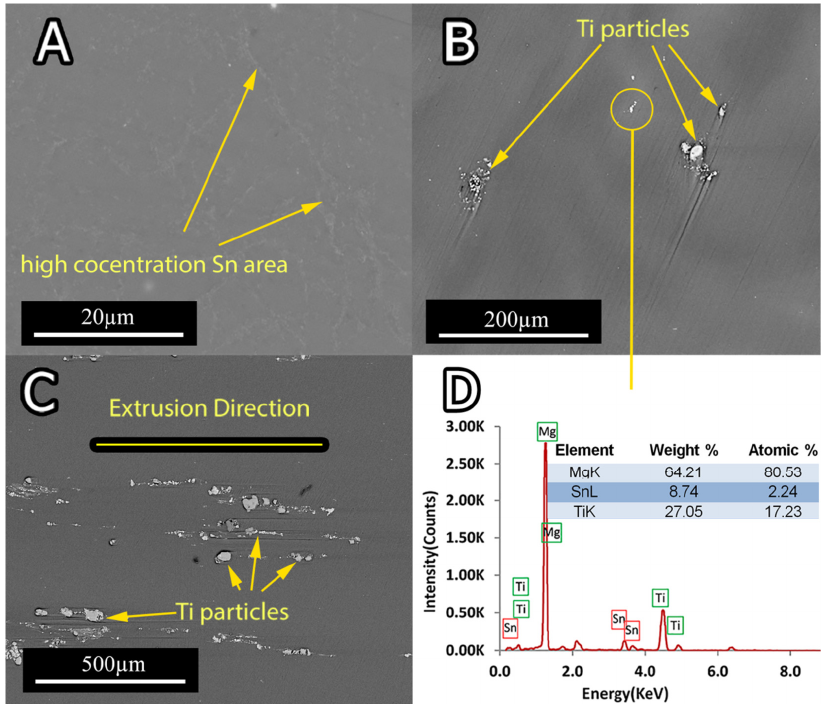
Figure 2. SEM micrograph of ( A ) the 0.15Ti sample perpendicular to the extrusion direction; ( B ) the 0.75Ti sample perpendicular to the extrusion direction; ( C ) the 1.5Ti sample along the extrusion direction; and ( D ) the EDXA spectrum of the selected area in ( B ).